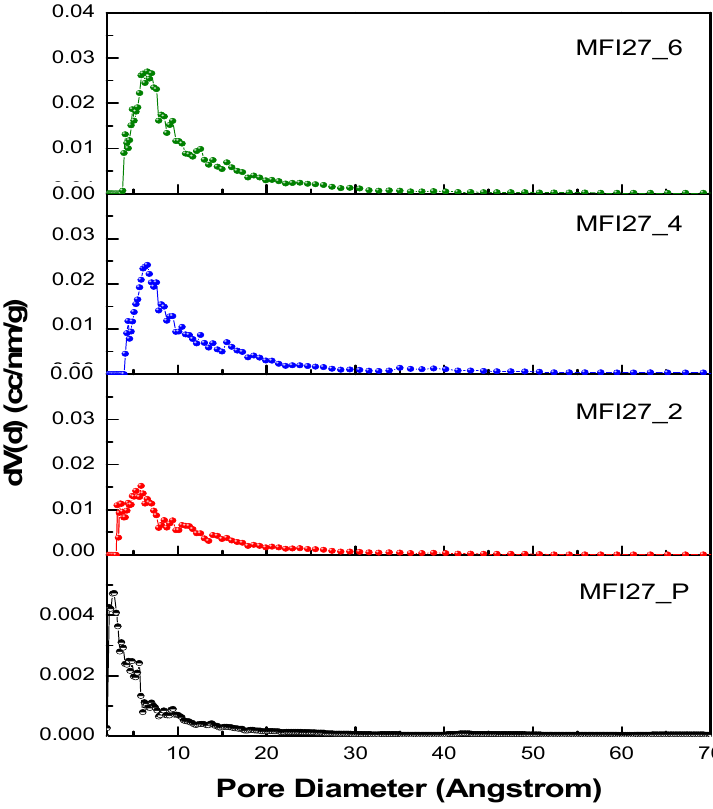
Figure 5. Pore size distribution of as-received ZSM-5 and alkali-treated zeolite samples. Table 2. Si/Al ratio, physicochemical properties of the parent and post modified zeolites.